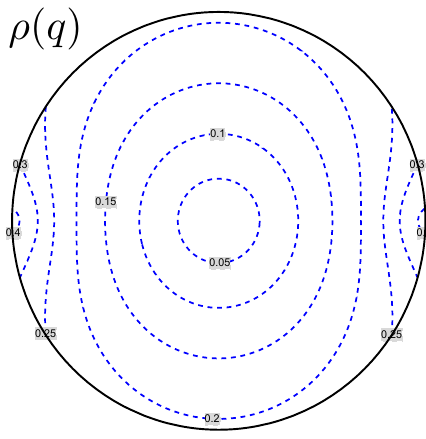
Figure 4 . This (cid:12)gure displays contours of constant to the entire z -plane via z = 4 (cid:26) to the region in the q -disk enclosed by the two blue lines connecting can have singularities in the OPE limits (cid:26)